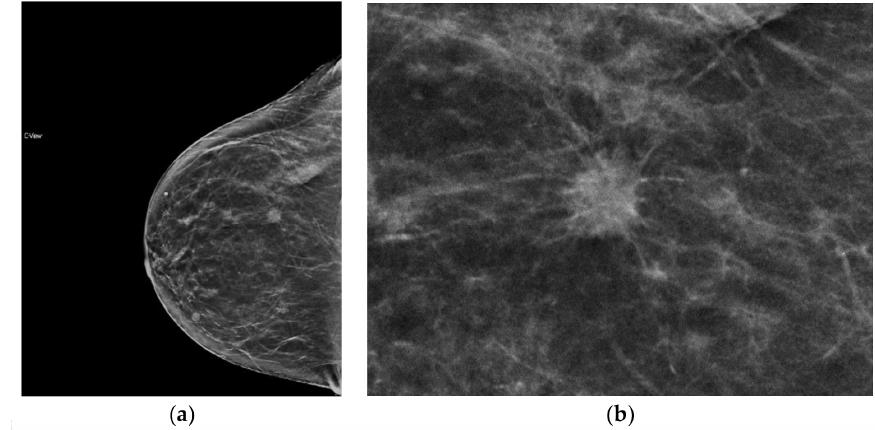
Figure 4. Mass, readily detected on synthesized mammography, with clear depiction of spiculated margin. Invasive ductal carcinoma, moderately differentiated, ER/PR+, Her2 − . ( a ) s2D RCC mass